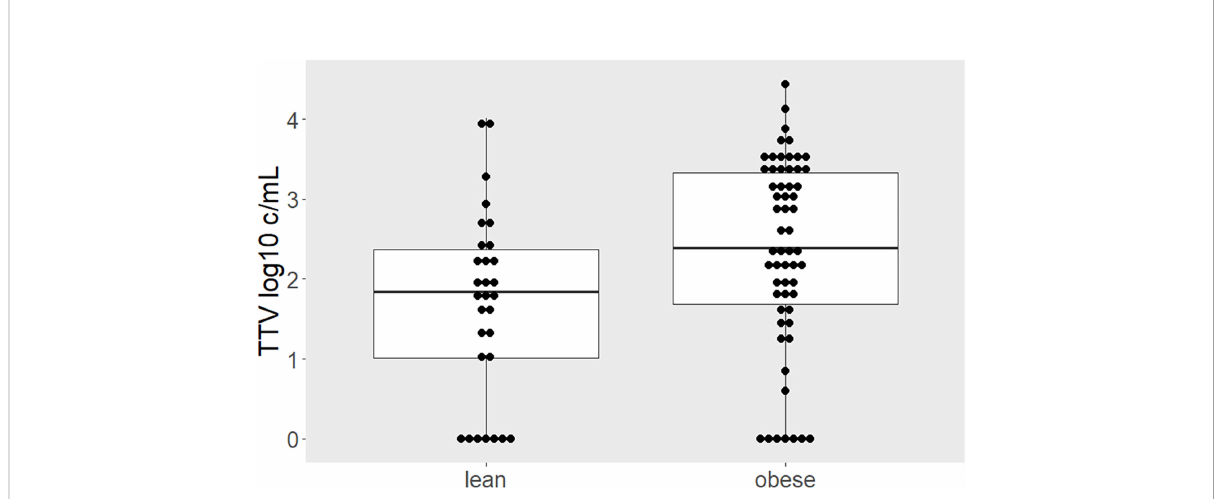
FIGURE 1 Higher TTV load in individuals with obesity. Comparison of TTV levels between lean and obese individuals depicted by boxplots superimposed by dots representing individual values. Higher TTV loads were quanti fi ed in obese compared to lean individuals ( p = 0.027). Between-group difference was estimated by Mann-Whitney-U